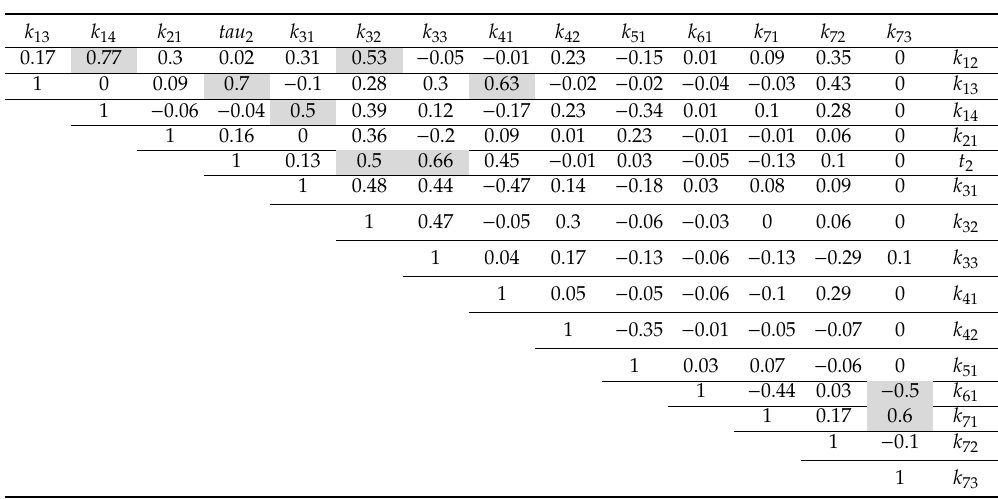
TableA1. PearsonCorrelationCoe ffi cientsforODEparametersfoundviaMCMC.Significantcorrelation pairs (Correlation coe ffi cient > ± 0.5) highlighted with Grey